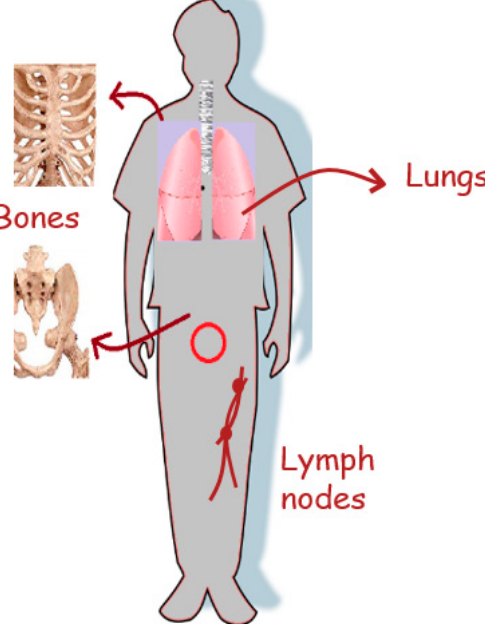
Figure 1. Representative image of the primary locations of prostate cancer (PCa) metastasis.